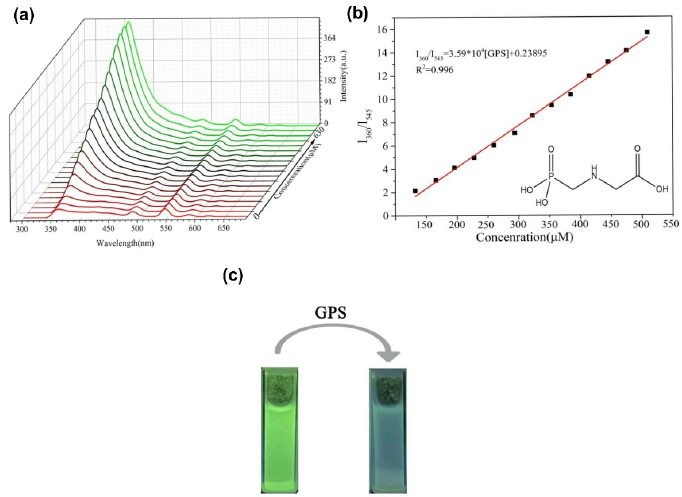
Figure 25. ( a ) The fluorescence spectra of Tb-MOF after different concentrations of GLYP; ( b ) Linear correlation of Tb-MOF and different concentration of GLYP; ( c ) The change of color for the Tb-MOF before and after adding GLYP. Reprinted with permission from [203]. Copyright 2021 Elsevier.